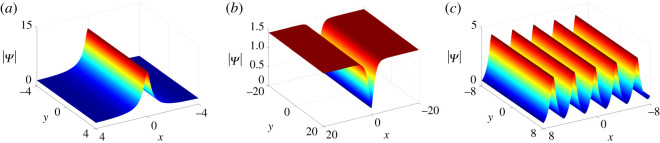
One-solitons and the periodic background of equation (1.3) at t = 0 with parameter values κ = 1, ξ10 = 0 and (a) α = 1/2, β = 0, μ = 1, ν = 29/10, (b) α = 1/2, β = 0, μ = −1, ν = 29/10, (c) α = 0, β = 1, μ = 1, ν = 2.